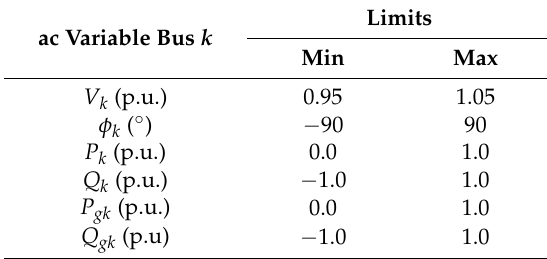
Table 2. AC variables range.